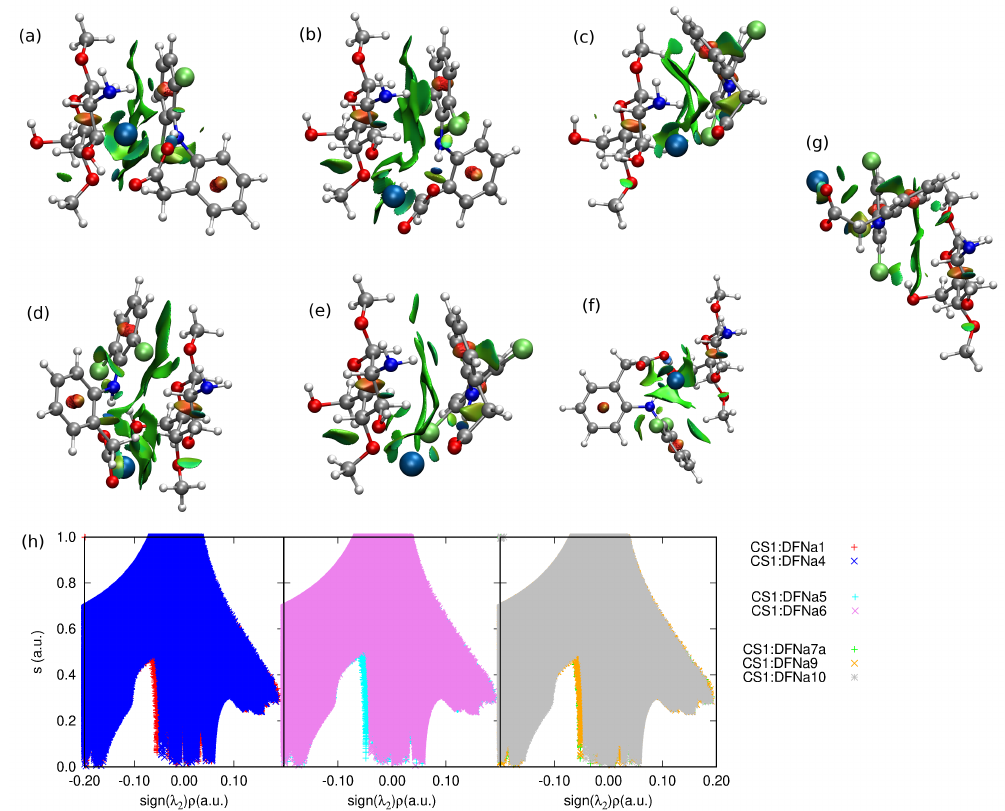
Figure 5. NCIPLOT of the most stable structures of chitozan unit interacting with DFNa: ( a ) CS1:DFNa 4 , ( b ) CS1:DFNa 1 , ( c ) CS1:DFNa 6 , ( d ) CS1:DFNa 5 , ( e ) CS1:DFNa 9 , ( f ) CS1:DFNa 7a , the weakest attraction ( g ) CS1:DFNa 10 and ( h ) the NCI relation between the reduced gradient, s and the sign of the second eigenvalue, λ 2 , of the electron-density Hessian. Atom colors: chlorine—lime green, oxygen—red, nitrogen—cobalt blue, carbon—silver,